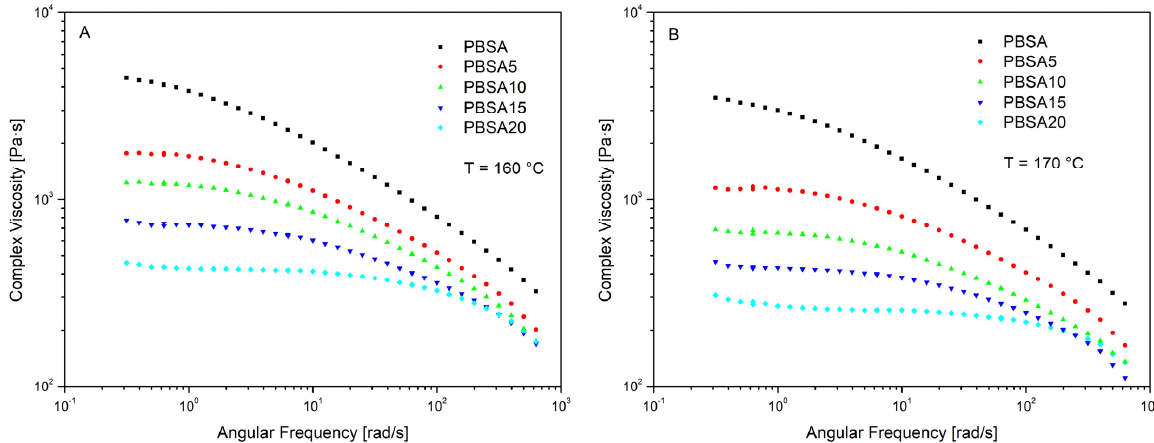
Figure 5. Complex viscosity versus angular frequency of PBSA and PBSA/BC composites at 160 °C ( A ) and 170 °C ( B ).